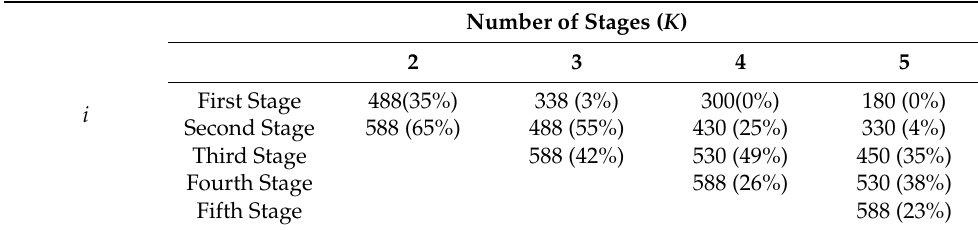
Table 7. Sample sizes and percentages of rejections of H 0 occurring at stage i with 500,000 iterations. Where P 1 = 0.1 and P 2 = 0.2 with α = 0.01, and the sample size equals